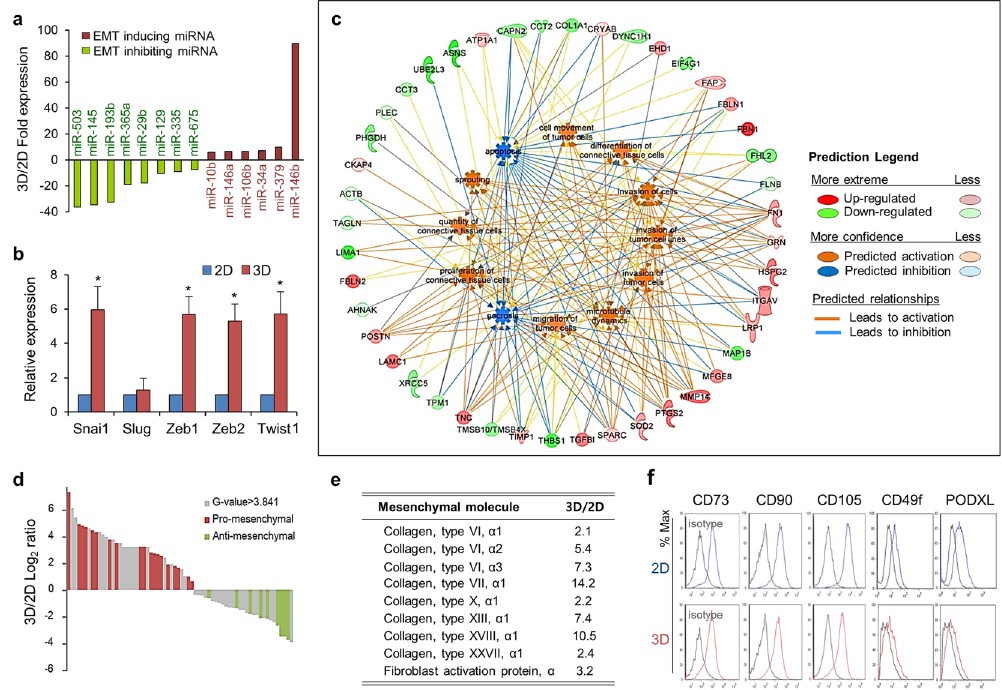
Figure 2. 3D spheroid MSCs were further driven towards the EMT. ( a ) Profiles of miRNAs regulating the EMT process among the top ranked 50 miRNAs exhibiting differential expression between 3D and 2D MSCs. The red bars indicate EMT-promoting miRNAs, and green bars indicate EMT-inhibiting miRNAs. ( b ) Induction of EMT-promoting molecules in 3D MSCs in comparison with those in 2D MSCs. Relative fold changes in the expression levels of the indicated genes were determined by qPCR with normalization to GAPDH levels (mean ± SEM, three experiments; n = 6; * p < 0.05). ( c and d ) Mesenchymal shift in the EMT gradient of 3D MSCs based on proteomic analysis. The non-redundant proteins identified in liquid chromatography-mass spectrophotometry for two independent sets of 3D and 2D MSCs were compared. ( c ) Differentially expressed proteins (G value > 3.841) were analyzed for functional annotations related to the EMT, and their networks were generated based on IPA analysis. Up- and downregulated proteins are indicated red and green, respectively. The regulated functions are colored by their predicted activation state: activated (orange) or inhibited (blue). The edges connecting the nodes are colored orange or blue for activation or inhibition of downstream nodes, respectively. ( d ) Shift of proteins towards the mesenchymal state. Proteins with significant differential expression (DEGs; gray) were aligned according to the order of the relative ratio (log 2 3D/2D) of expression levels. Among the DEGs, all proteins annotated to increase the EMT were marked with red, and proteins annotated to inhibit the EMT were marked with green. ( e ) Fold changes in mesenchymal molecules in 3D spheroid MSCs relative to expression levels in 2D MSCs. The expression levels of representative mesenchymal molecules in 3D MSCs relative to those in 2D MSCs were analyzed from RNA-seq data. ( f ) The expression of surface markers for MSCs was determined for 2D and 3D cultured MSCs by flow cytometry. The black graph indicates the isotype control, the blue and red graphs indicate 2D or 3D MSCs,